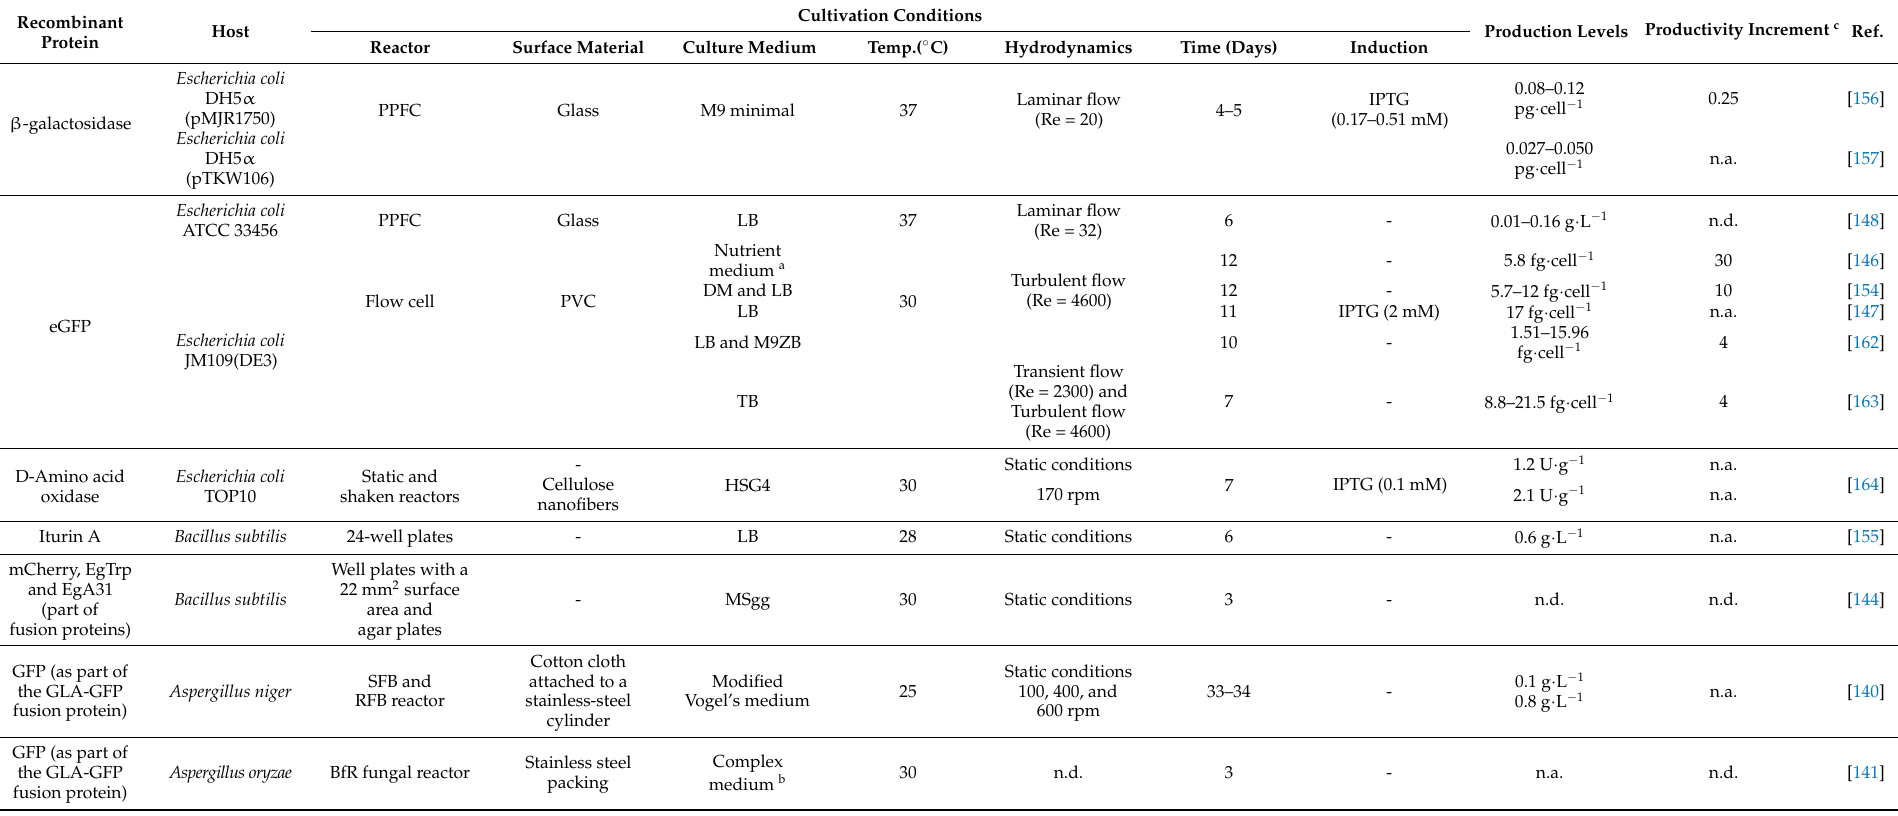
Table 8. Synopsis of the published work on the production of recombinant proteins in bacterial